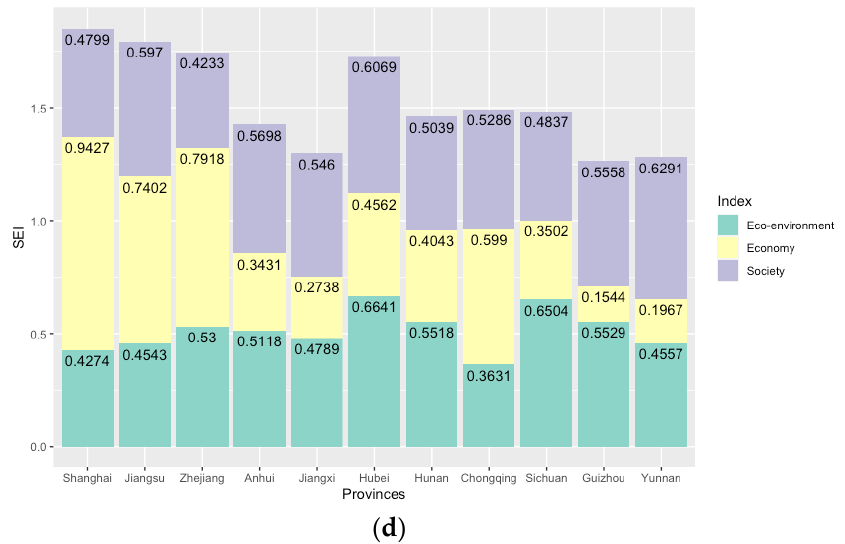
Figure 8. Calculation results of basic characteristic index: ( a ) water microsystem security index; ( b ) energy microsystem security index; ( c ) food microsystem security index; ( d ) symbiosis environ- ment index.